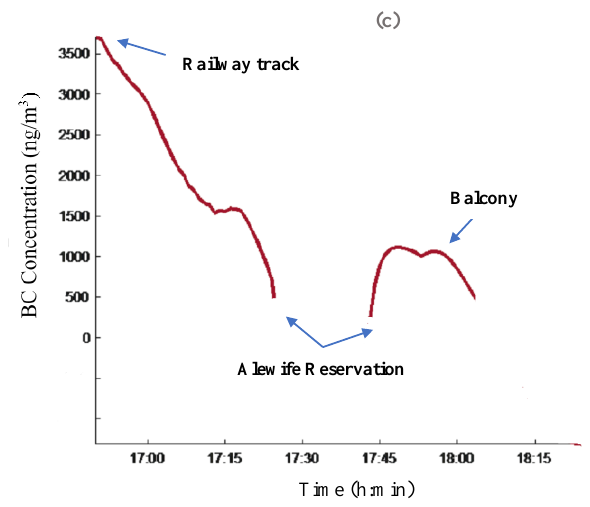
Figure 4. ( a ) PM 10 , ( b ) PM 2.5 , and ( c ) BC exposure concentrations for a walk in Boston (Campaign 2). Note: MicroAeth AE51 background noise (or negative values) were excluded from BC exposure analysis.